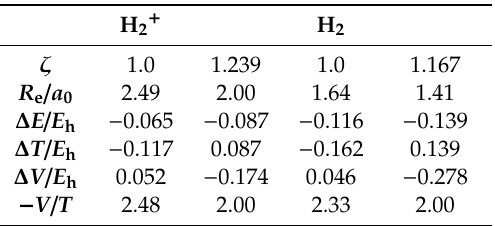
Table 1. H 2 + , H 2 : Computed molecular energies ( E ) and their kinetic ( T ) and potential ( V ) components (relative to H and H + H, respectively) at their equilibrium bond lengths ( R e ) with fixed and optimized orbital exponents.